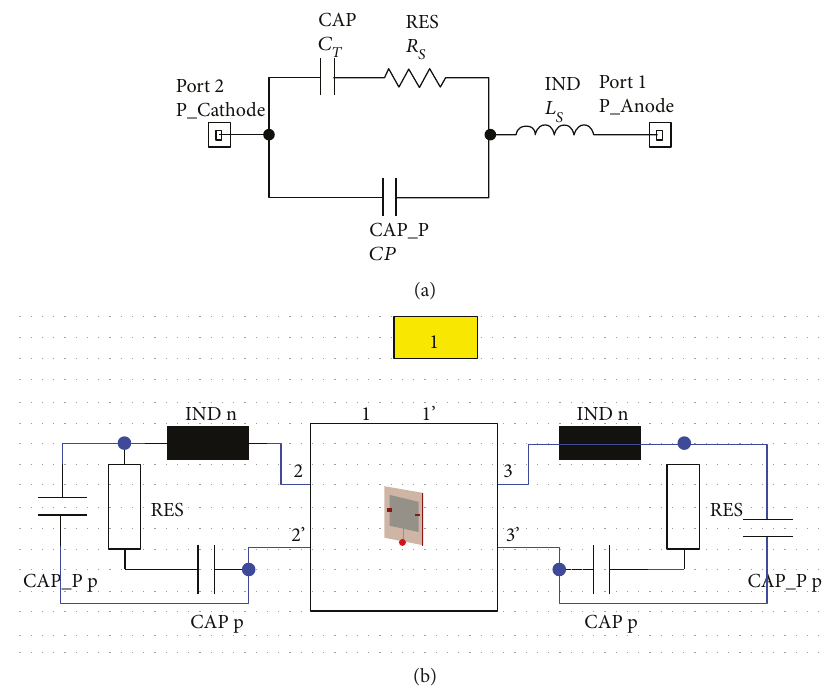
Figure 11: (a) Equivalent circuit of the diode varactor. (b) Schematic design of the antenna.